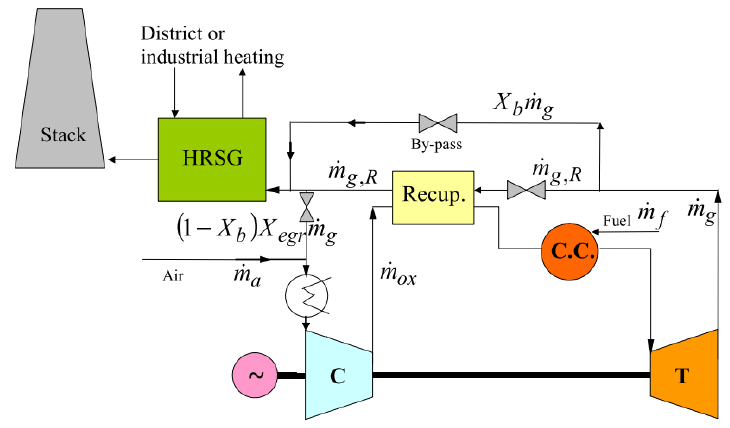
Figure 1. Plant layout of the recuperated micro-gas turbine with the EGR option